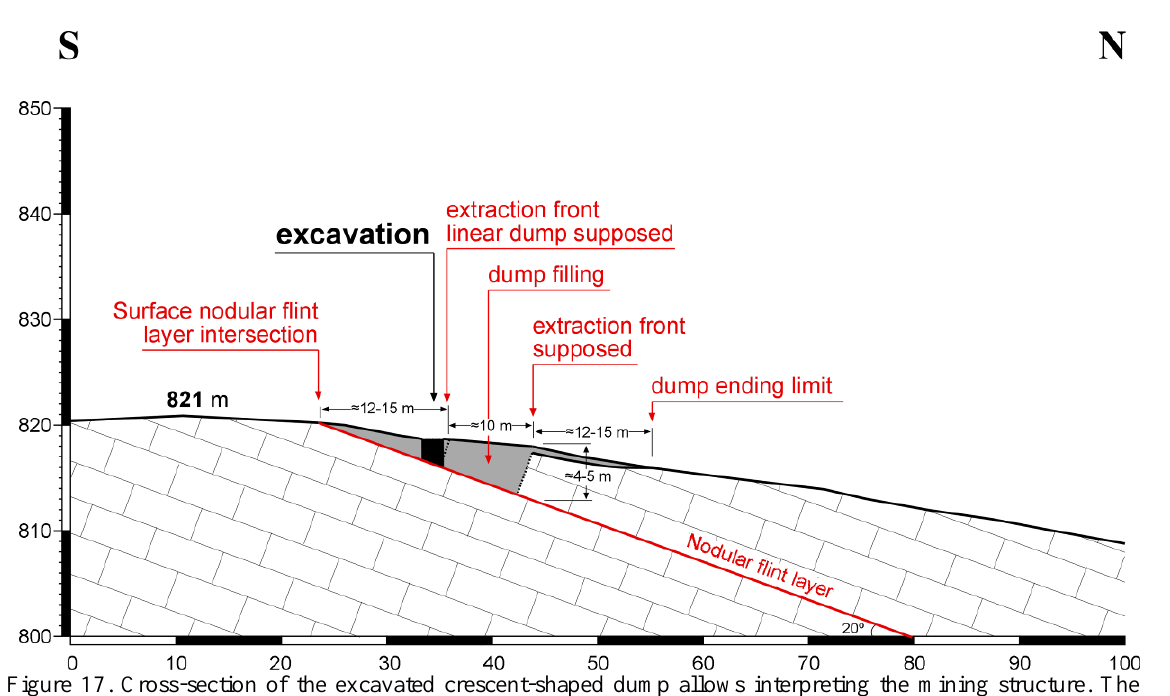
Figure 17. Cross-section of the excavated crescent-shaped dump allows interpreting the mining structure. The layer of flint might crop out many metres uphill and the exploitation have advanced till the height reached by the extraction front might make impossible its